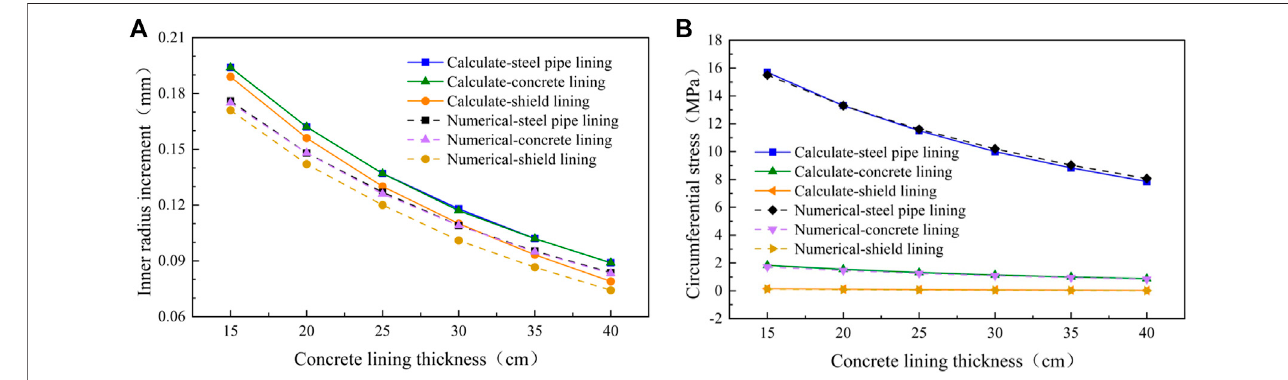
FIGURE 10 | In fl uence of concrete lining thickness on structural stress and deformation. (A) Inner radius increment. (B) Circumferential stress at the inner radius.